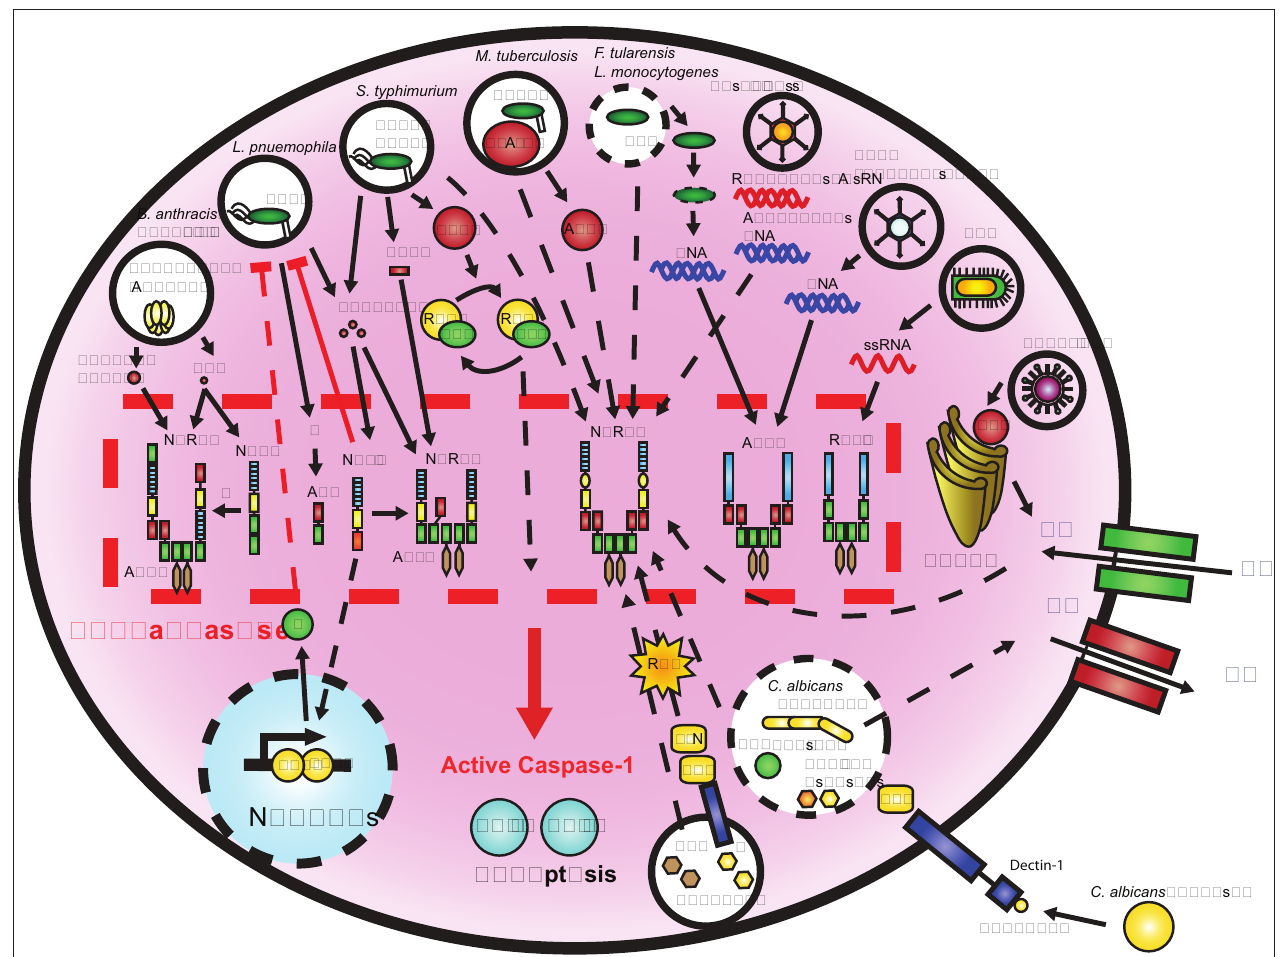
which escape the phagosome activate AIM2 that senses cytosolic DNA. B. anthracis lethal toxin activates the NLRP1 inflammasome. C. albicans and hemozoin activate NLRP3 through SYK signaling. Viral-mediated inflammasome activation is heavily dependent on the detection of nucleic acids by NLRP3, AIM2, and RIG-I. Dotted lines indicate signaling through an unknown